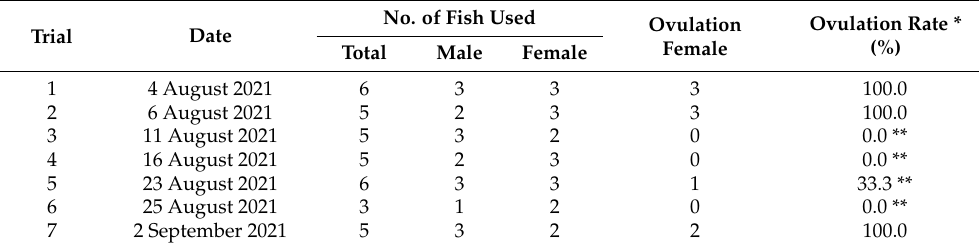
Table 1. The ovulation rate of females in a series of artificial fertilization